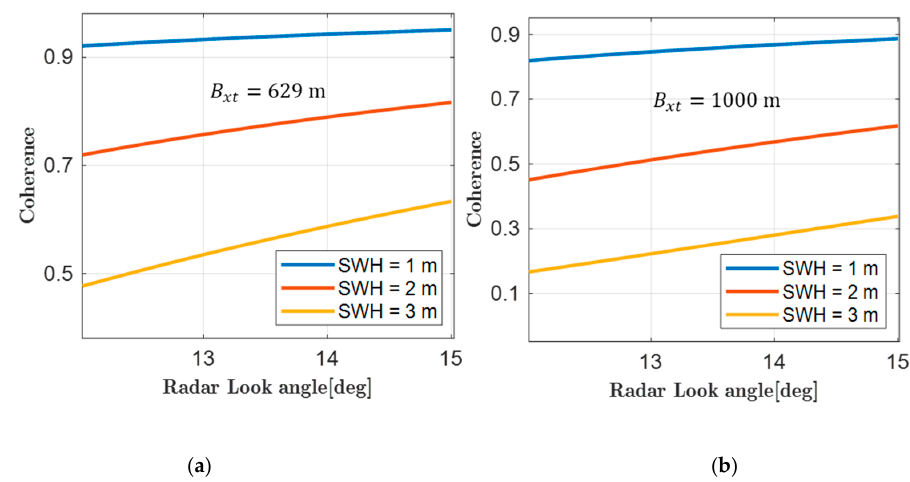
Figure 13. Coherence determined by wave volume decorrelation. ( a ) Cross-track baseline length of 629 m, and ( b ) cross-track baseline length of 1000 m.